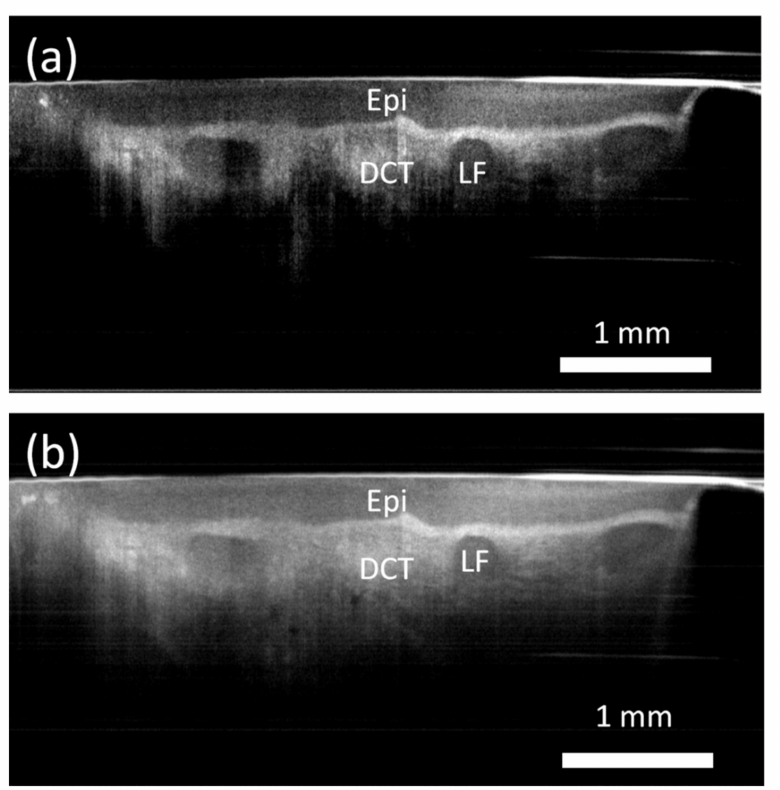
Figure 2. ( a ) Cross-sectional cross-polarized image of the tonsil tissue. ( b ) Cross-sectional co-polarized image of tonsil tissue at the same location as the top image. Different features such as the reticulated crypt epithelium (Epi), dense connective tissue (DCT), and lymphoid follicles (LF) can be visualized.